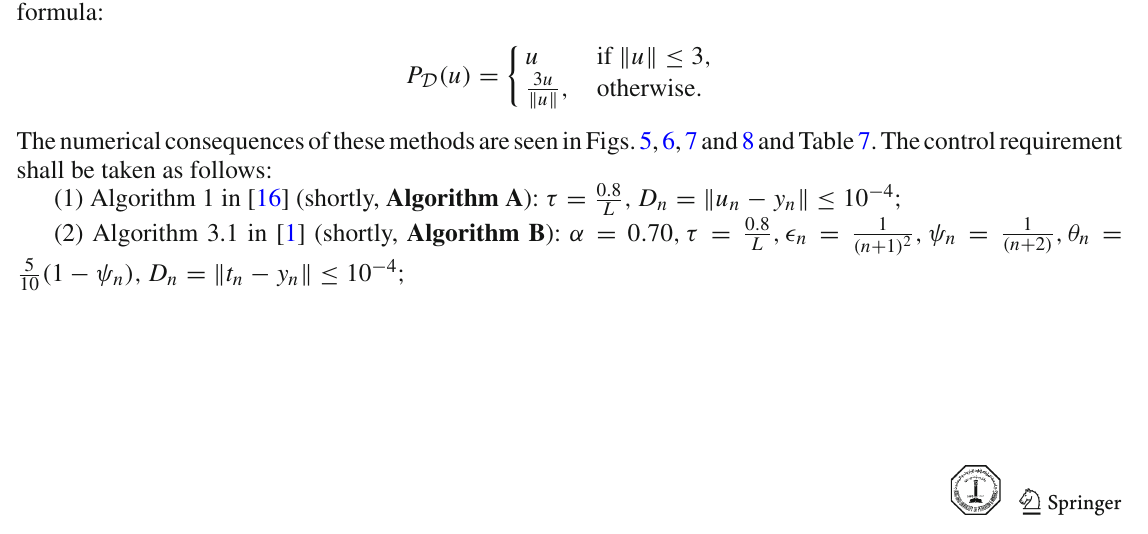
Fig. 5 Numerical illustration of Algorithm 1 with Algorithm 1 in [16] and Algorithm 3.1 in [1] and Algorithm 3.1 in [27] while u 0 = u 1 = ( 1 , 1 ,..., 1 5000 , 0 , 0